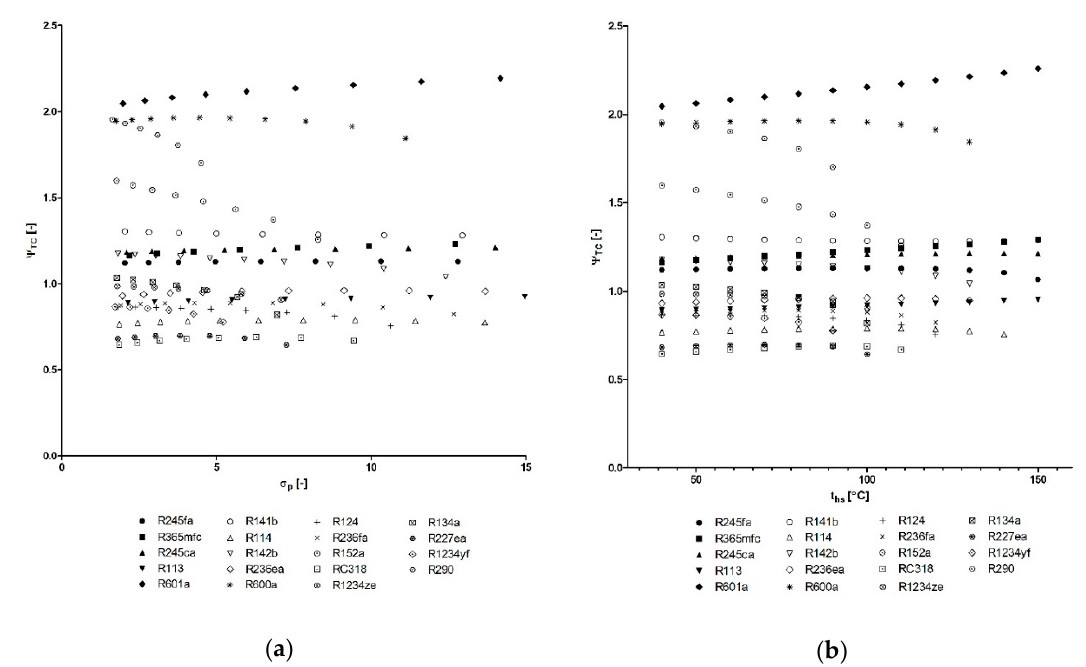
Figure 12. The variation of the ψ TC parameter vs. the pressure expansion ratio and heat source temperature: ( a ) ψ TC = f( σ P ); ( b ) ψ TC = f(t hs ).